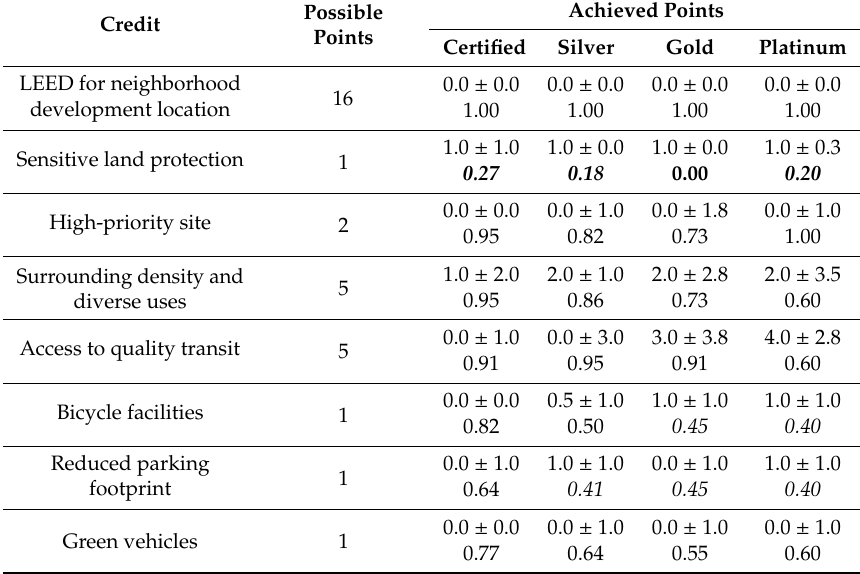
Table 2. Credit points achieved for Location and Transportation category of LEED-NCv4 projects: median ± interquartile range (IQR, 25th–75th) and Cli ff ’s δ e ff ect size of di ff erences between possible and achieved points in a